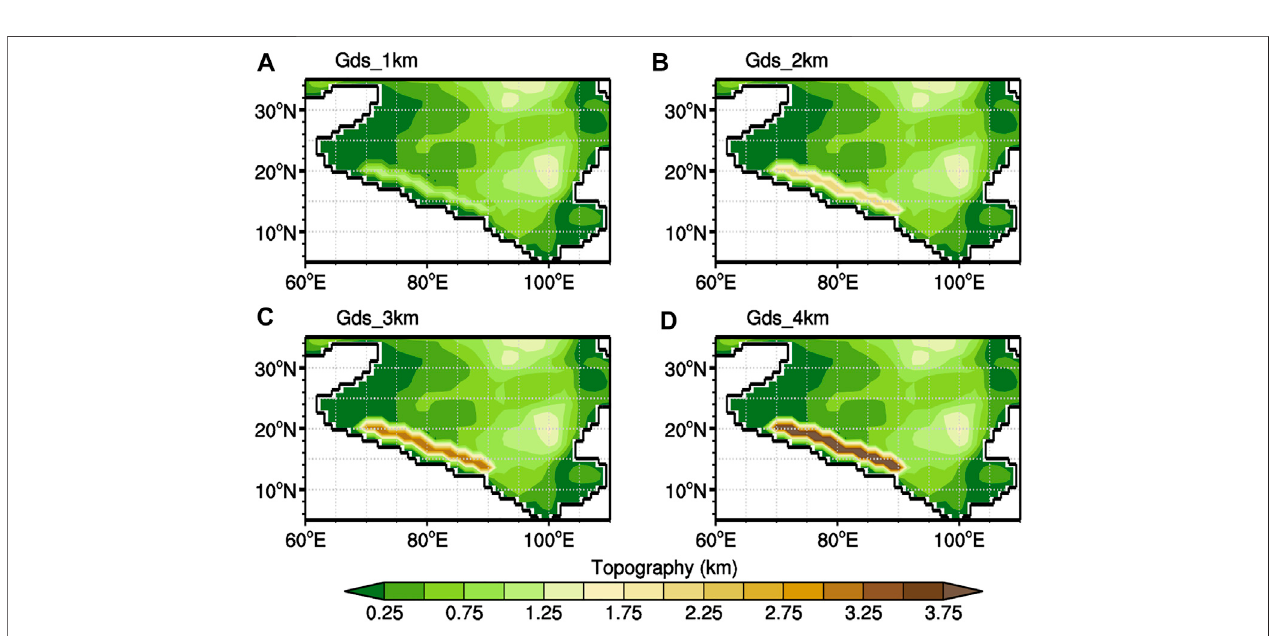
FIGURE 2 | The altitude of the Gangdese Mountains for the experiments Gds_1 km (A) , Gds_2 km (B) , Gds_3 km (C) and Gds_4 km (D) .